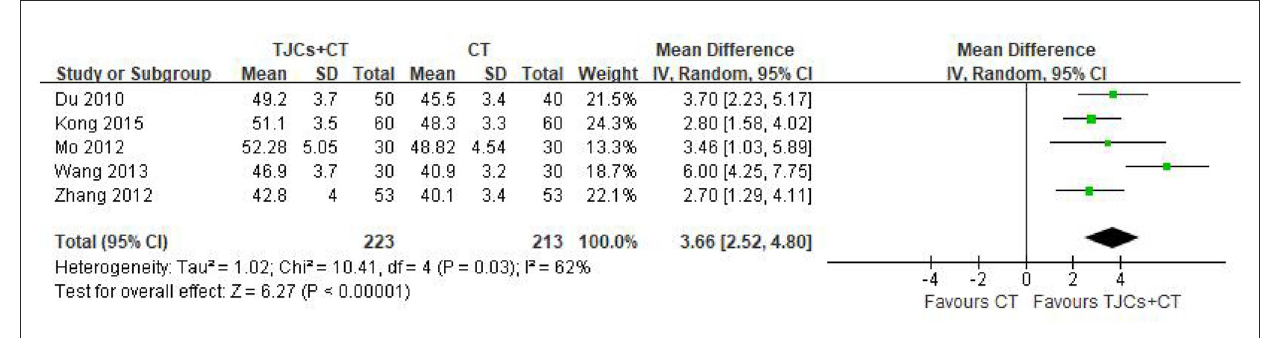
FIGURE5 Forest plot of Median nerve SNCV (m/s).